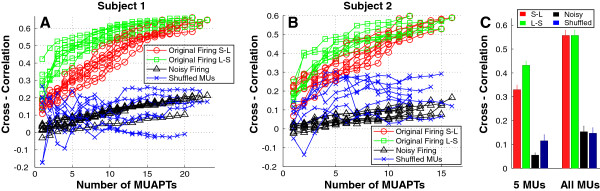
Cross-correlation between MUAP trains and raw EMG. A: Cross-correlations between EMG and sequentially added MUAP trains using original firings from small to large MU indices are shown in circles. Cross-correlations calculated using original firings from large to small MU indices are shown in squares. Cross-correlations calculated using noisy firings (SD of noise = 0.1 * SD of ISIs) are shown in triangles. Cross-correlations calculated using shuffled STA templates are shown in crosses. B: Cross-correlation results of a second subject. The symbol notations are the same as in subject 1. C: Cross-correlations when the first 5 MUAPTs were added together and when all MUAPTs were added. Error bars represent the standard errors across all the subjects.